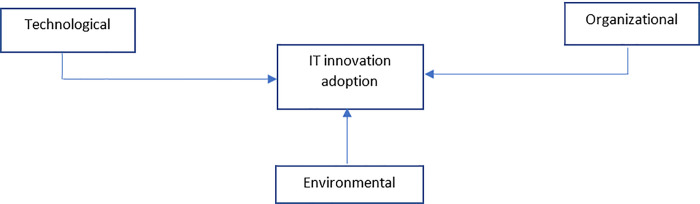
Technology, organization and environment framework by [90].